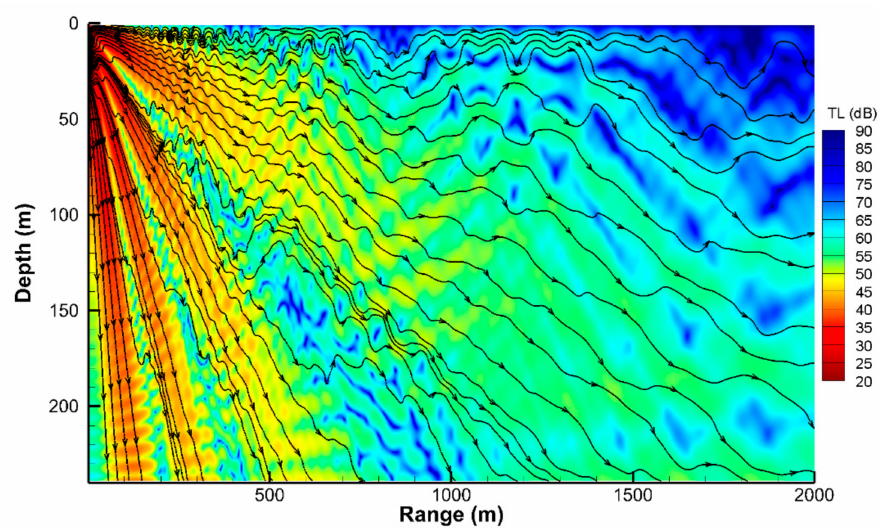
Figure 9. TL contours and TASI streamlines for the Bucker waveguide (4th-order